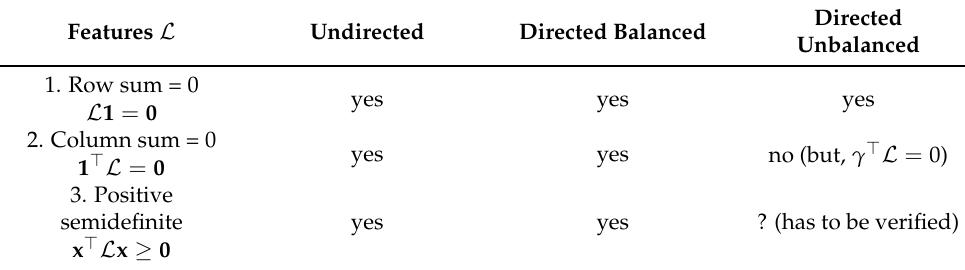
Table 1. Main properties of L for the different graph